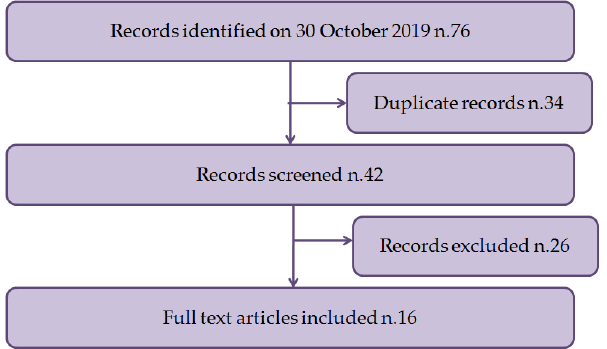
Figure 1. Flow diagram illustrating included and excluded studies in this systematic review.